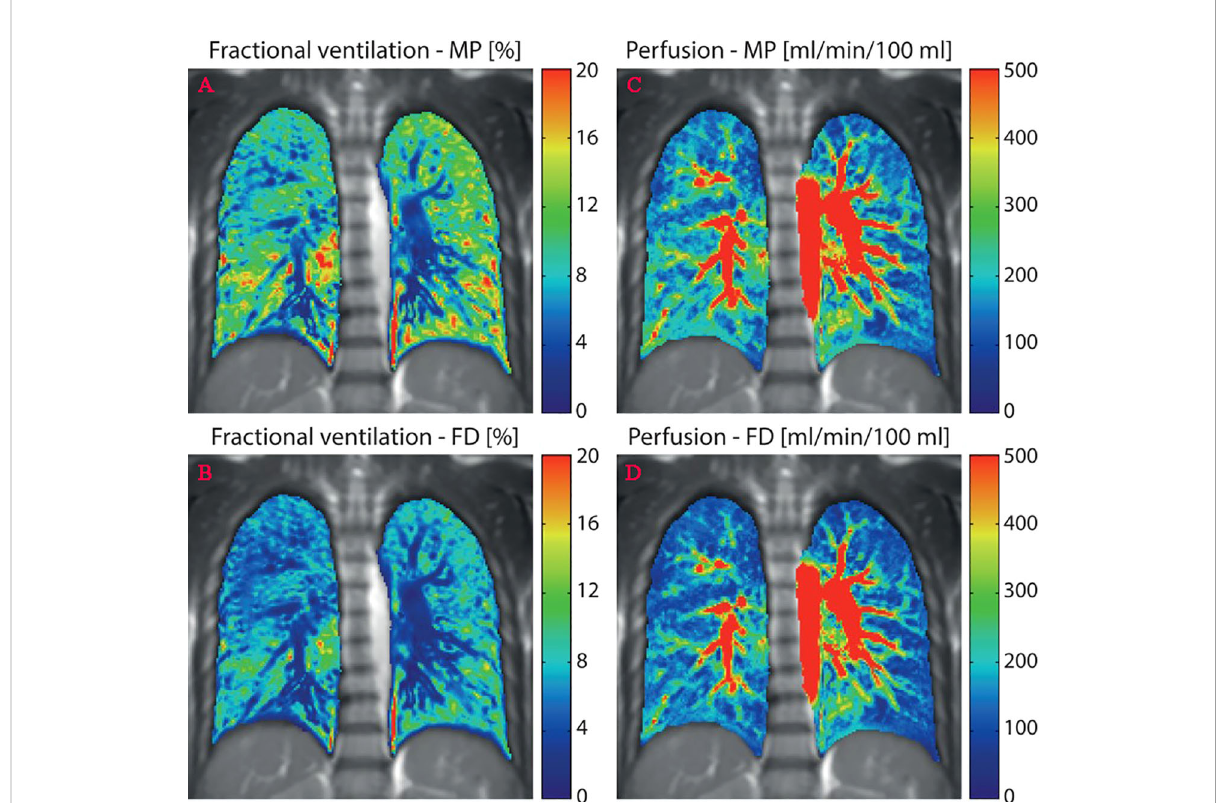
FIGURE 2 Quantitative maps of ventilation and perfusion calculated using the matrix pencil (MP) and Fourier decomposition (FD) methods. (A, C) , MP-MRI ventilation/perfusion; (B, D) , FD-MRI ventilation/perfusion. Reproduced from reference (64) with permission from Wiley, copyright